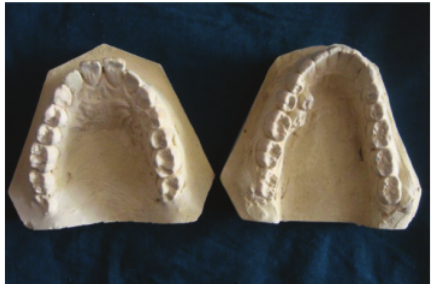
Figure 2: Model cast of maxillary and mandibular arch with the pathology.